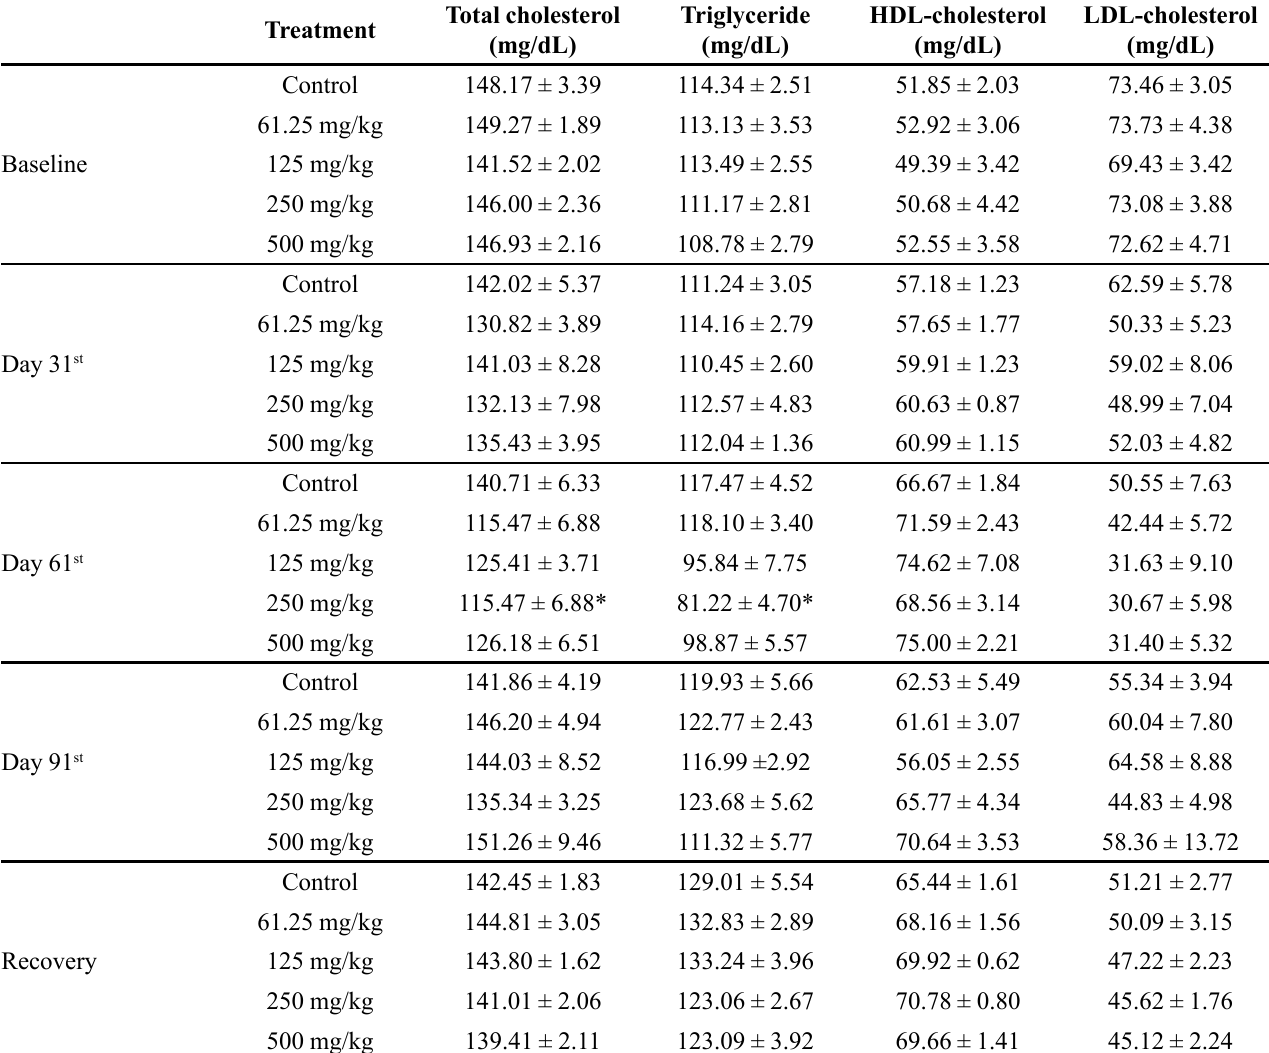
TABLE V - Effect of sub-chronic administration of Dryopteris filix-mas ethanol leaf extract on Lipid profile of albino